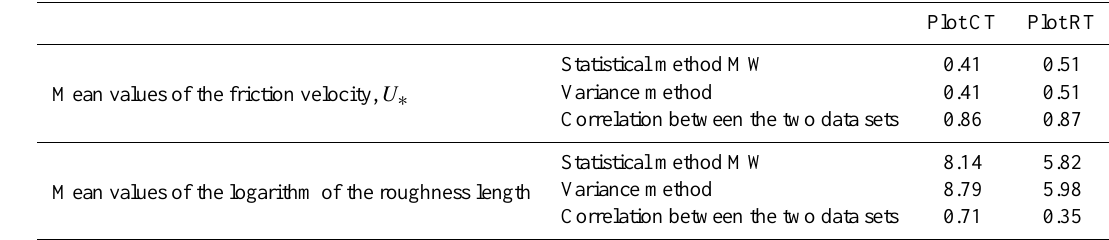
Table 7. Comparison parameters between the values of the friction velocity and the roughness stemming from the statistical method MW and the variance method, for α =1.16 and δ =1.4 (25 July 1997, over 24h).